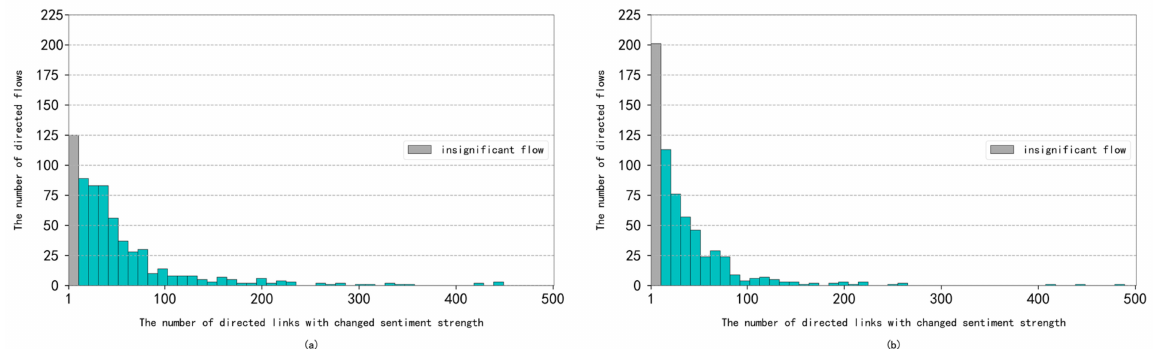
Figure 4. The number of distributions of directed links with changed sentiment strength in each directed flow in daytime ( a ) and nighttime ( b